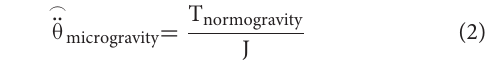
(cid:0) ¨ θ (cid:1) and angular position ( θ ) when participants reached to T1 and T2 targets, we calculated for each participant and target, the net (cid:0) (cid:1) and gravitational J ¨ θ respectively ( Figure 7A